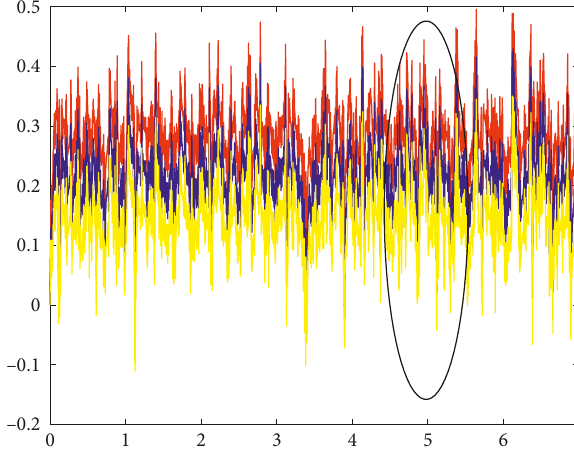
Figure 12: The weight vectors w